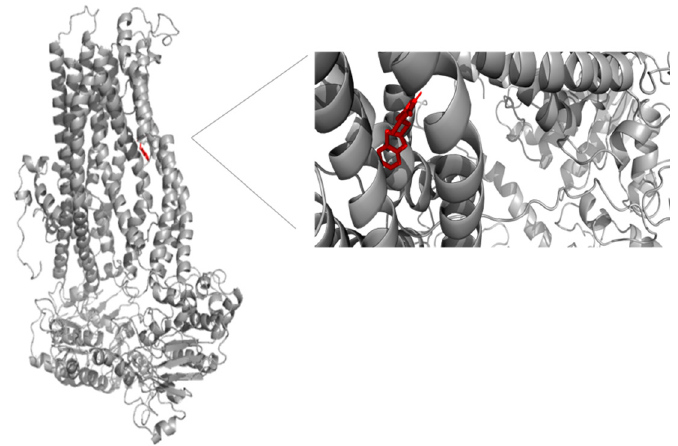
Figure 9. Representation of the full MRP4 structure in complex with 6-MP, and a close up to the 6-MP binding site. 6-MP is represented by the rainbow-colored structure.